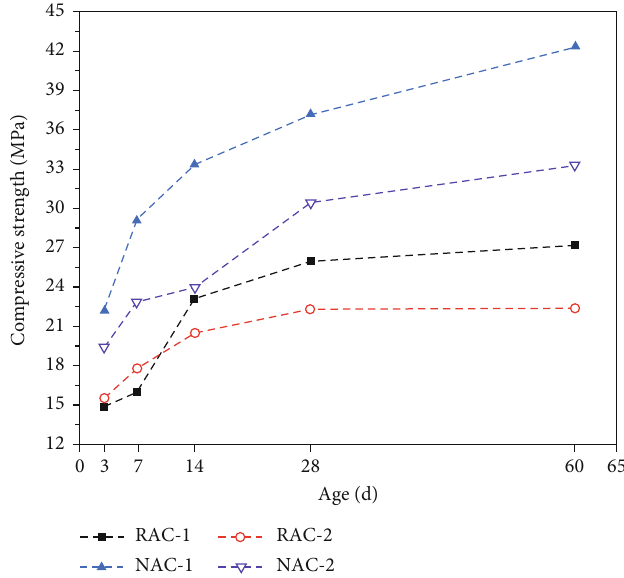
Figure 5: The compressive strength of NAC and RAC with di ff erent